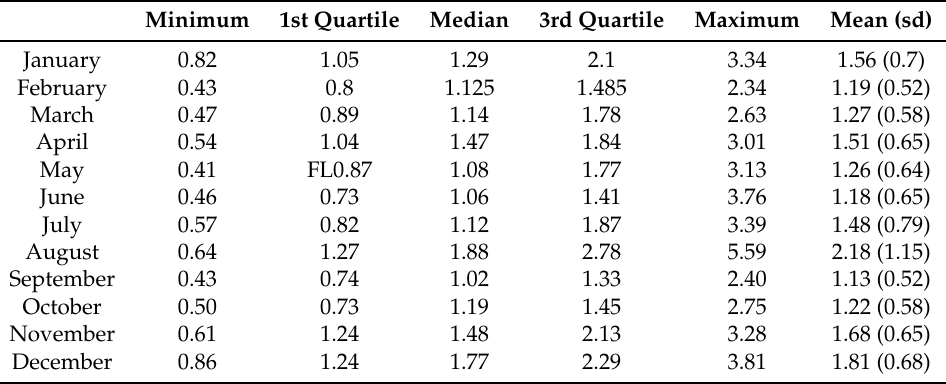
Table 18. Monthly MAPE (in %) for FSSM model (11) on RTE load demand